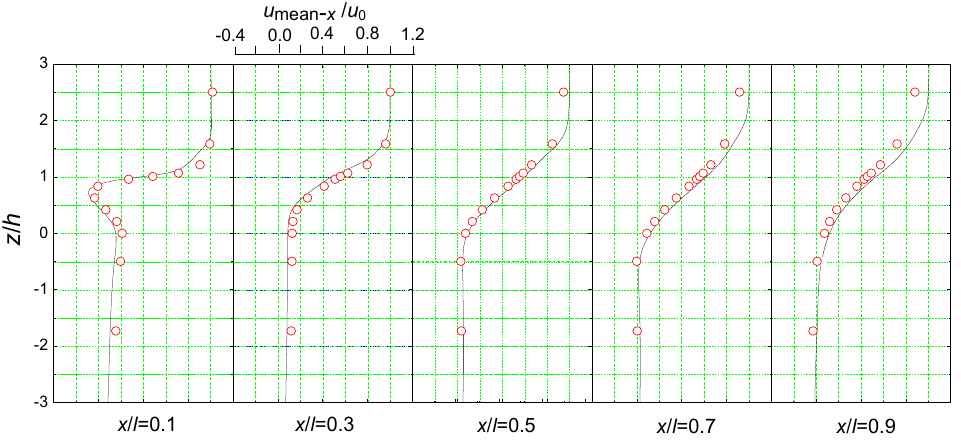
Figure 3. Mean streamwise velocity profile at the cavity opening. Note: circles represent experimental values and solid lines represent simulated values.